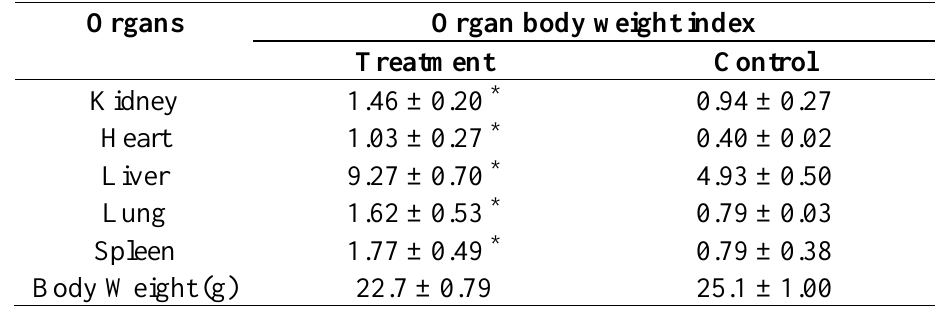
Table 3. Effect of C. fistula seeds crude extract on organ-to-body weight index (%) in